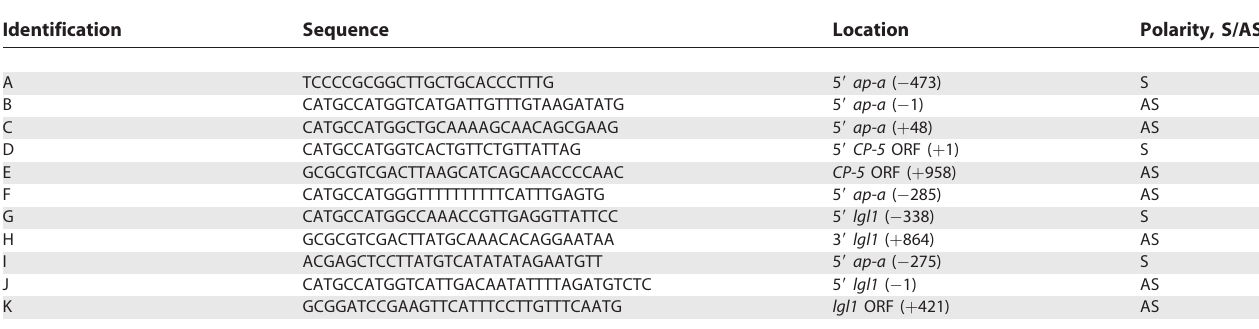
Table 2. Primers Used for Plasmid